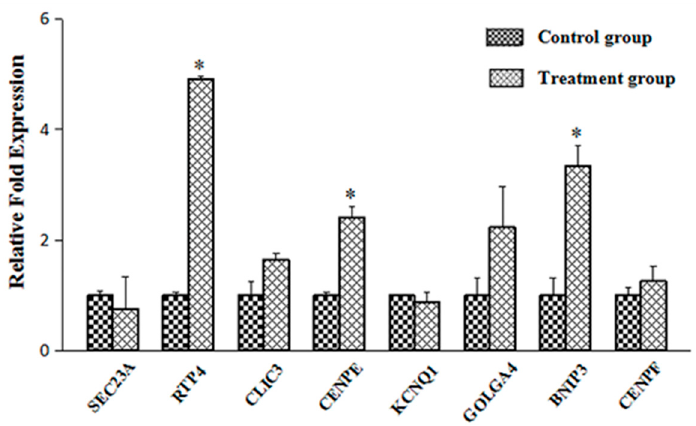
Figure 2. Expression levels of α -TTP related genes. SEC23A : Sec23 homolog A; RTP4 : receptor transporter protein 4; CLIC3 : chloride intracellular channel 3; CENPE : centromere protein E; KCNQ1 : potassium voltage-gated channel subfamily Q member 1; GOLGA4 : golgi autoantigen, golgin subfamily a, 4; BNIP3 : BCL2/adenovirus E1B 19 kDa interacting protein 3; CENPF : centromere protein F. Data are presented as mean ± standard error; the asterisk indicated significant difference between control and treatment group.